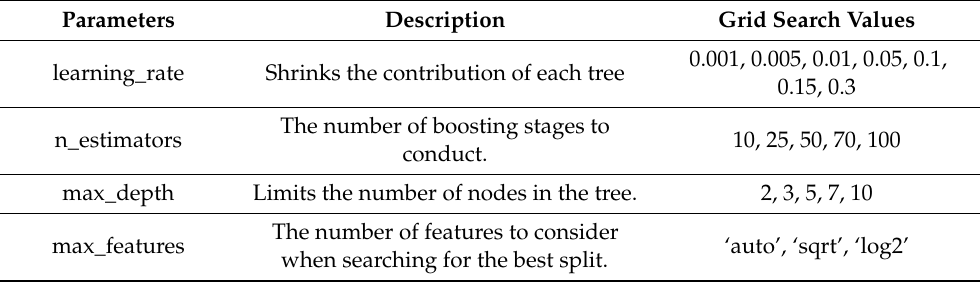
Table 5. GridSearchCV parameters for the GB and XGB algorithms. Parameters Description Grid Search Values 0.001, 0.005, 0.01, 0.05, 0.1, learning_rate Shrinks the contribution of each tree 0.15, 0.3 The number of boosting stages to 10, 25, 50, 70, 100 n_estimators conduct. max_depth Limits the number of nodes in the tree. 2, 3, 5, 7, 10 The number of features to consider ‘auto’, ‘sqrt’, max_features when searching for the best split.